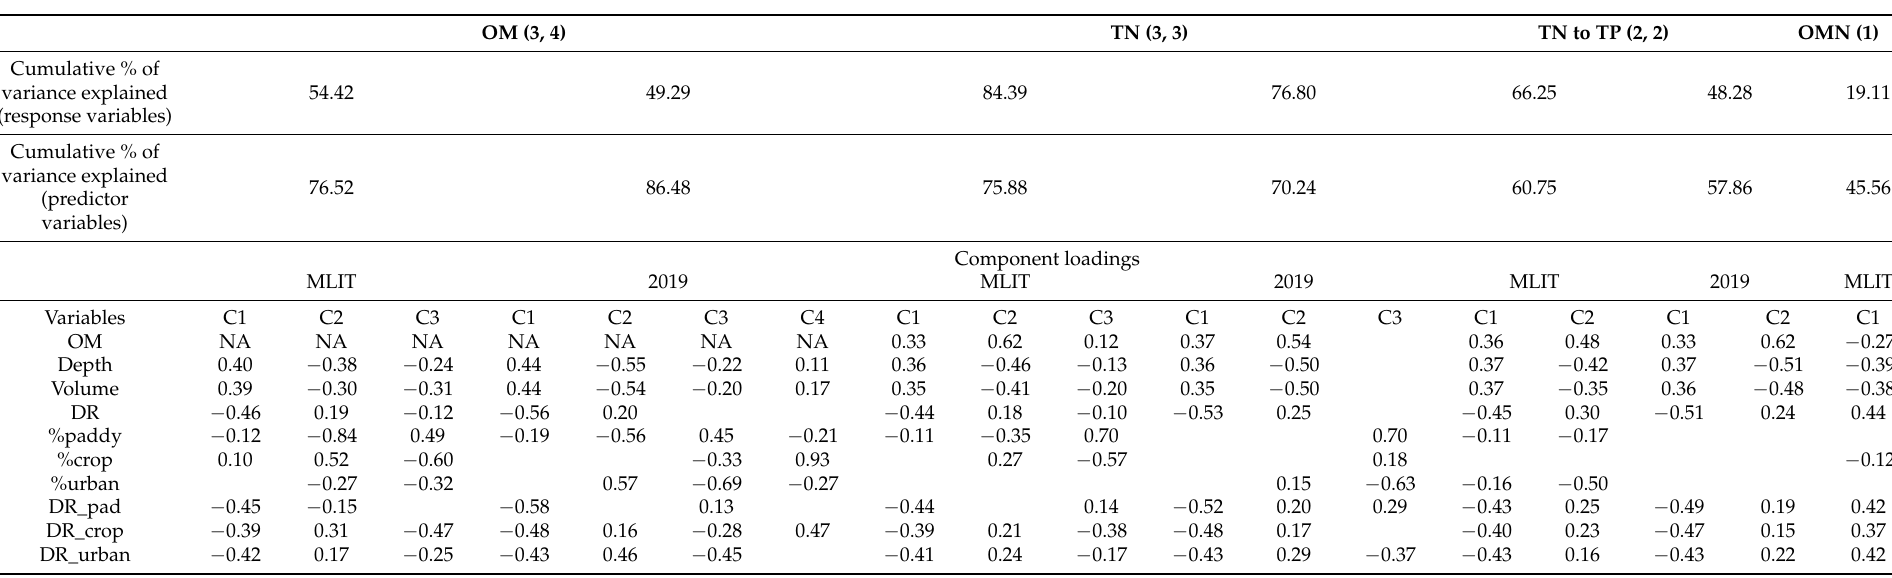
Table 3. Output of partial least square (PLS) regression relating predictor variables to four response variables of sediment characteristics in floodplain water bodies. “MLIT” refers to data collected by MLIT whereas data collected in 2019 was shown as “2019”. Loading with absolute values less than 0.1 are not shown (–). Components (C) for organic matter to nitrogen (OMN) ratio in data collected in 2019 is not shown because no acceptable PLS model was developed. “NA” denote not applicable. Other abbreviations: DR for drainage index; DR_pad, DR_crop and DR_urban for drainage index based on the total area of paddy fields, crop fields, urban areas, respectively; %paddy, %crop, and %urban for the proportion of paddy fields, crop fields, and urban